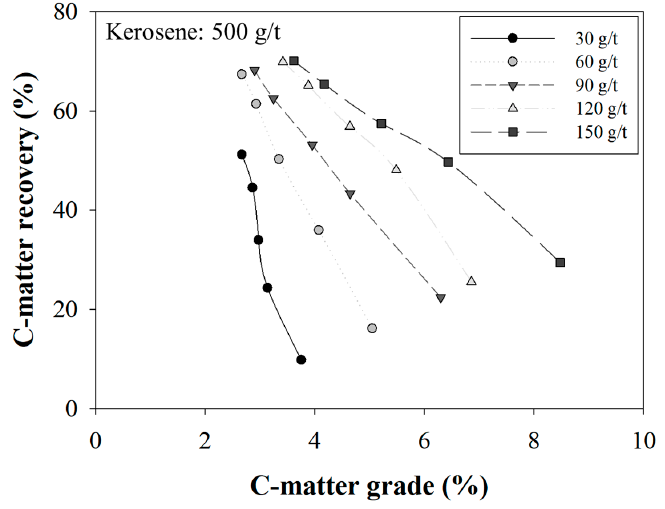
Figure 4. C-matter grade vs. C-matter recovery for different MIBC dosages: kerosene dosage, 500 g/t; agitation speed, 1200 rpm.